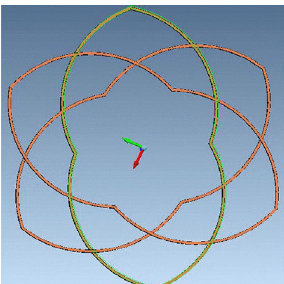
Figure 27 Winding structure proposed in Ref.